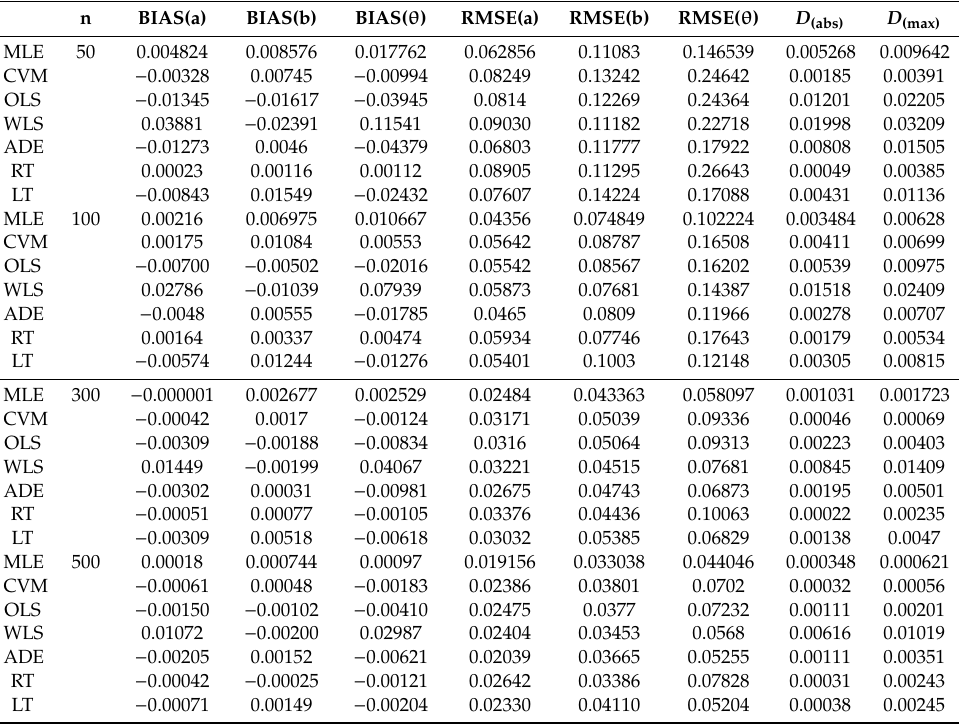
Table 5. Simulation results for parameters a = 0.5, b = 0.75, and θ =